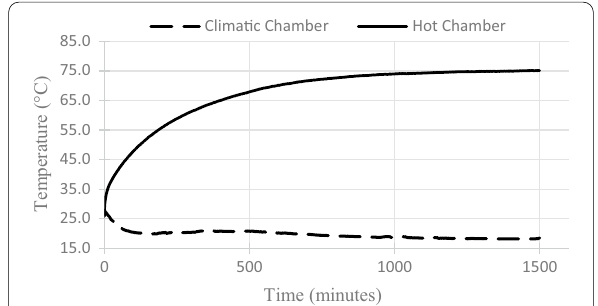
Fig. 5 Hot and climatic chambers air temperature.